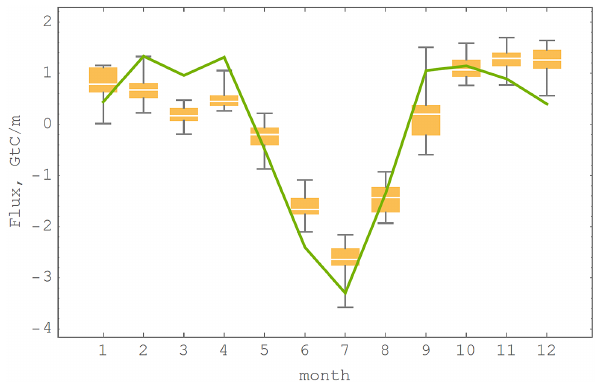
Figure 4. The seasonal cycle of N a,mod (green) for WUE = 2.7gCL − 1 , Q 10 = 1.4, and φ = 0.2, as compared to the detrended TransCom 3 seasonal CO 2 flux (orange) estimated from atmospheric inversions (Gurney and Denning,